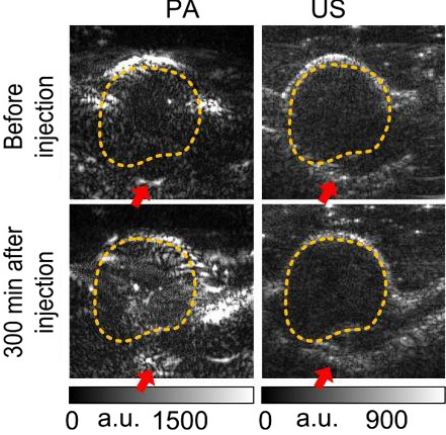
Fig. 6. In vivo PA images of a xenograft prostate tumor in rat before and after PAA NP injection (left), compared with US imaging (right). Dashed contour lines mark the tumor region; red arrows mark the blood vessels connecting to the tumor. The in vivo PA images exhibit enhanced contrast of the tumor, whereas no change can be observed in the pure US